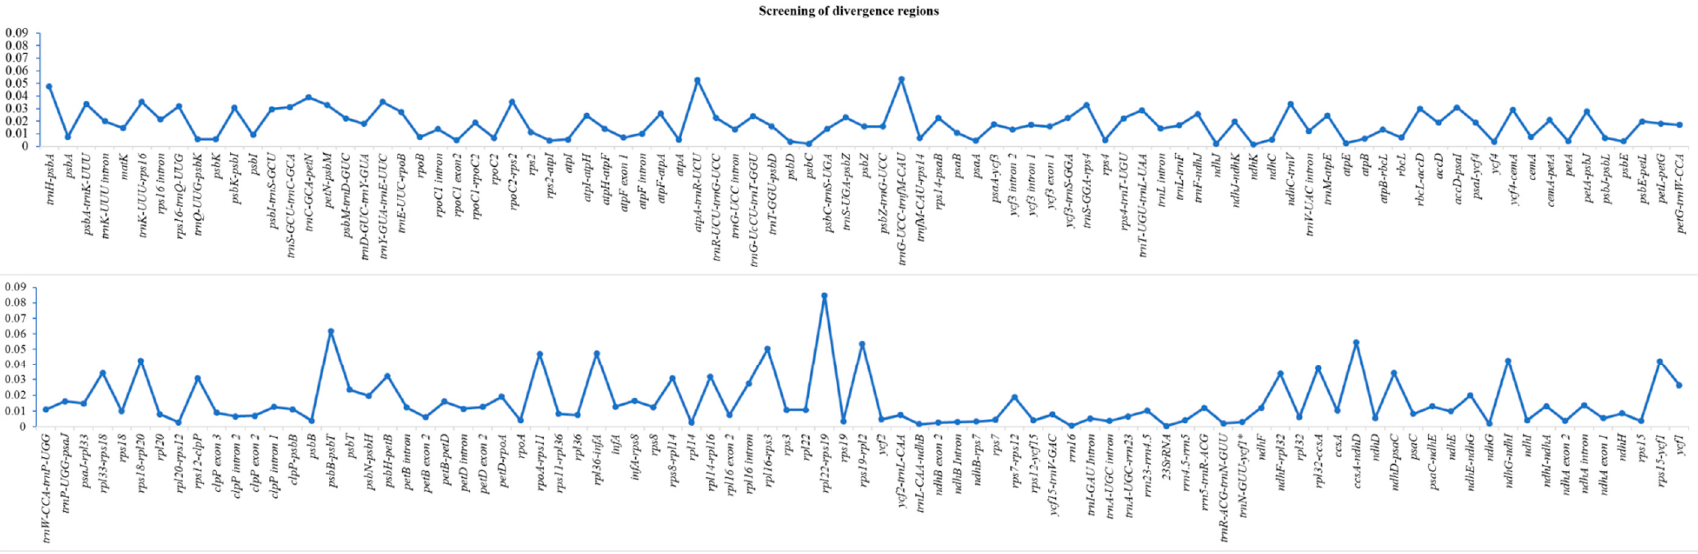
Figure 3. The x-axis shows the regions of the chloroplast genome and the y-axis shows the nucleotide diversity of each region. The regions with 0 nucleotide diversity are not included in the list.